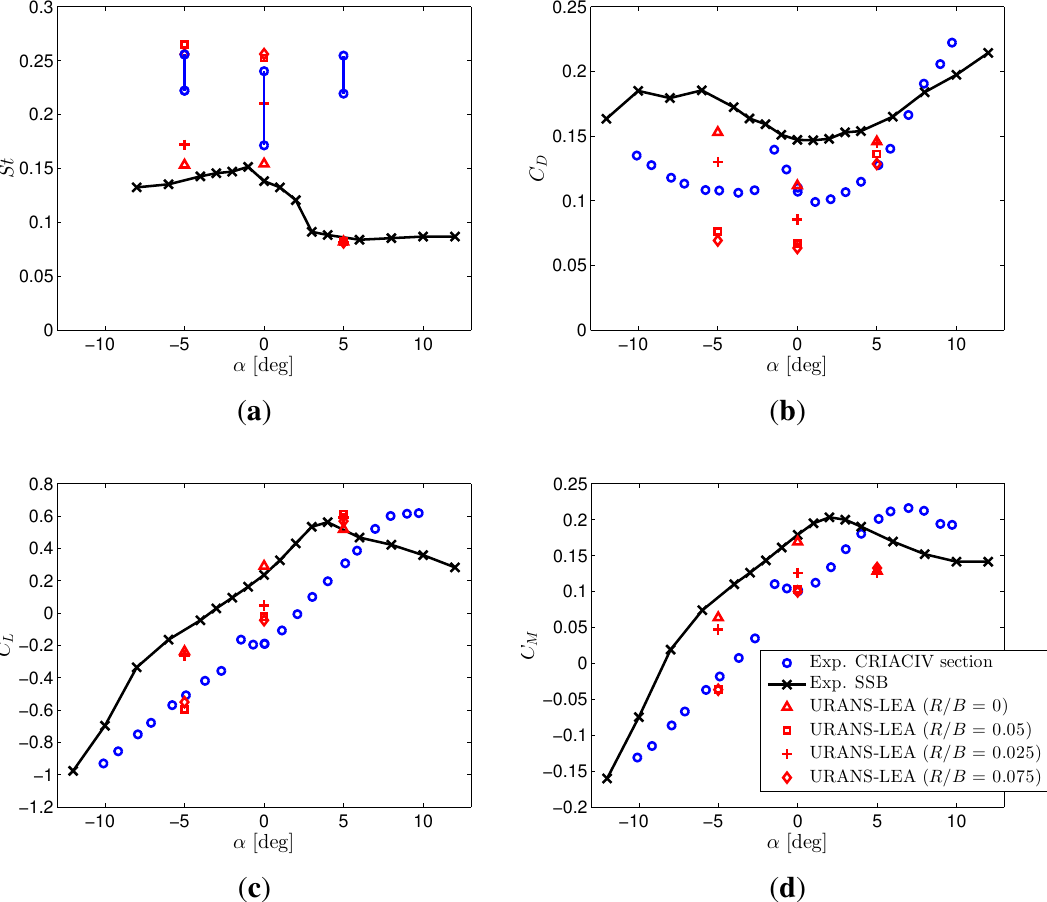
Figure 19. Strouhal number ( a ), drag ( b ), lift ( c ) and moment ( d ) coefficients at various angles of